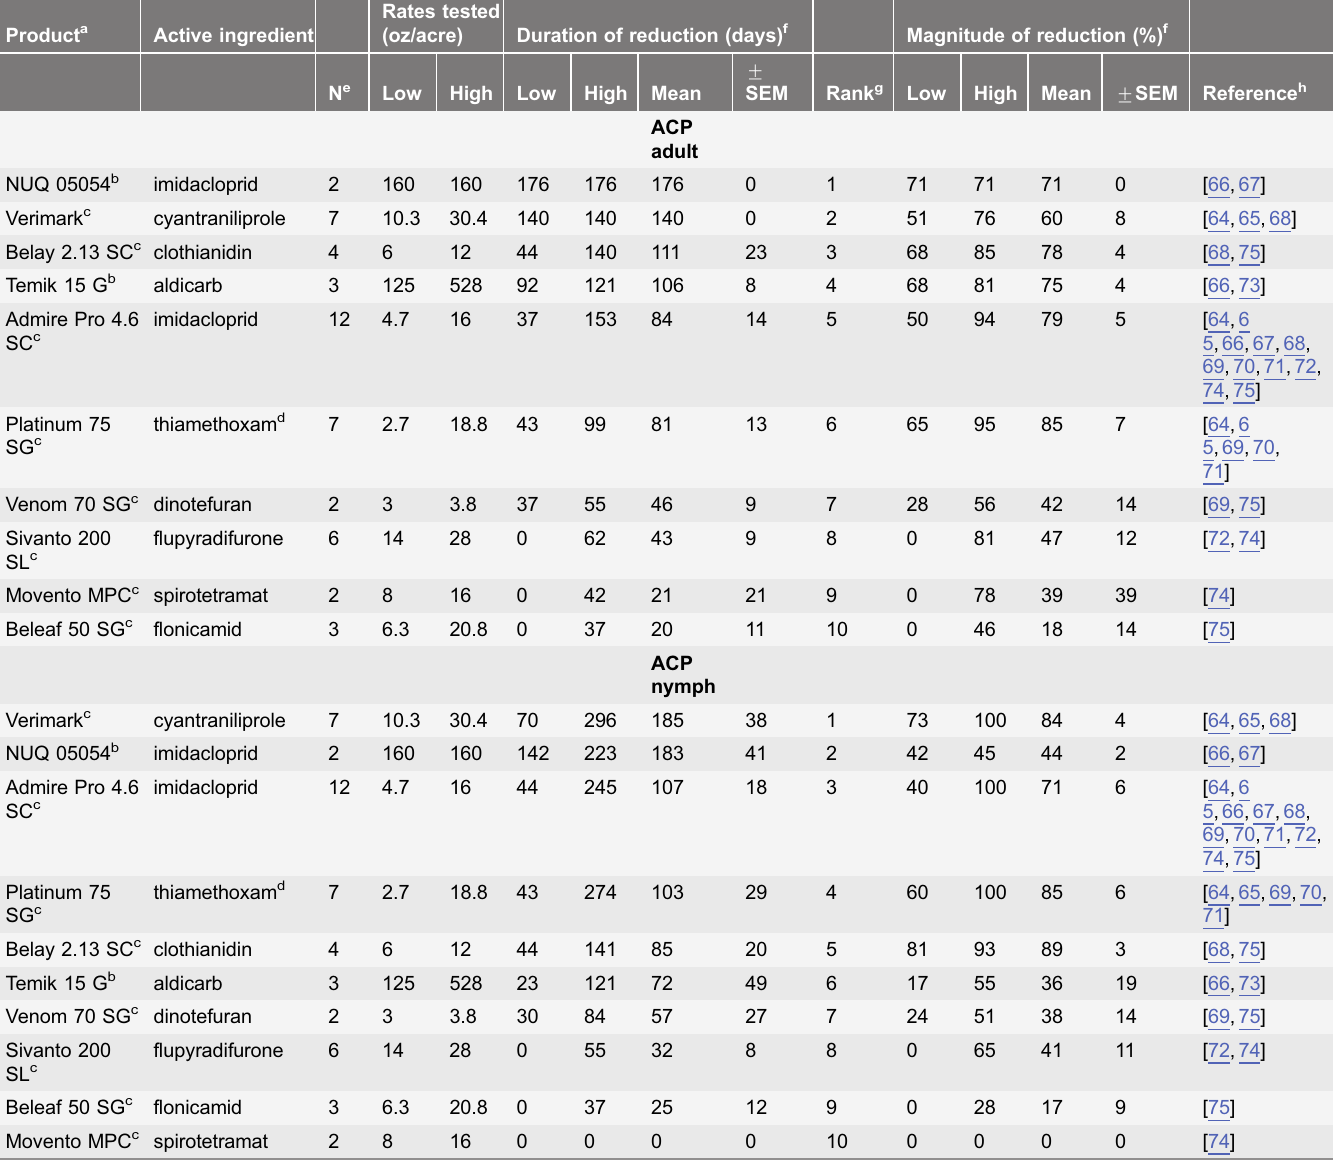
Table 5. Duration and magnitude of reduction of Diaphorina citri adults and nymphs on orange trees treated with soil applications of insecticides in Florida. Product